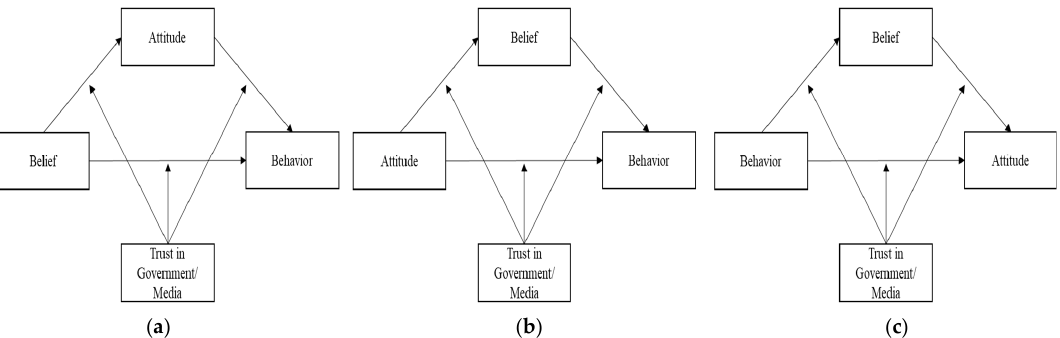
Figure 4. The three models (high involvement ( a ), low involvement ( b ), and hedonic model ( c )) with trust in government and media.